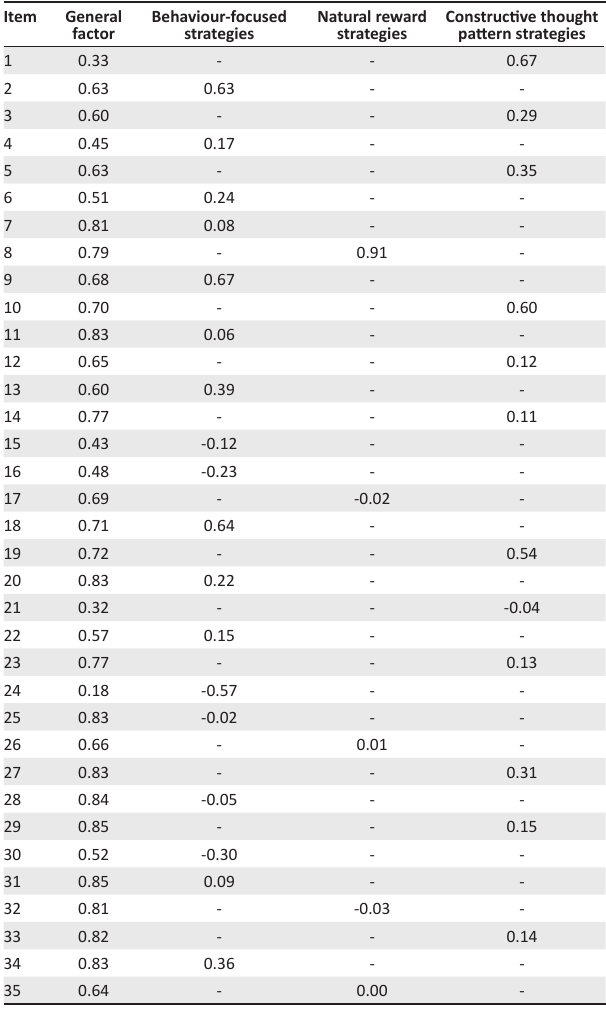
TABLE 2: Standardised factor loadings for the bifactor model (RSLQ, n = 405). Item